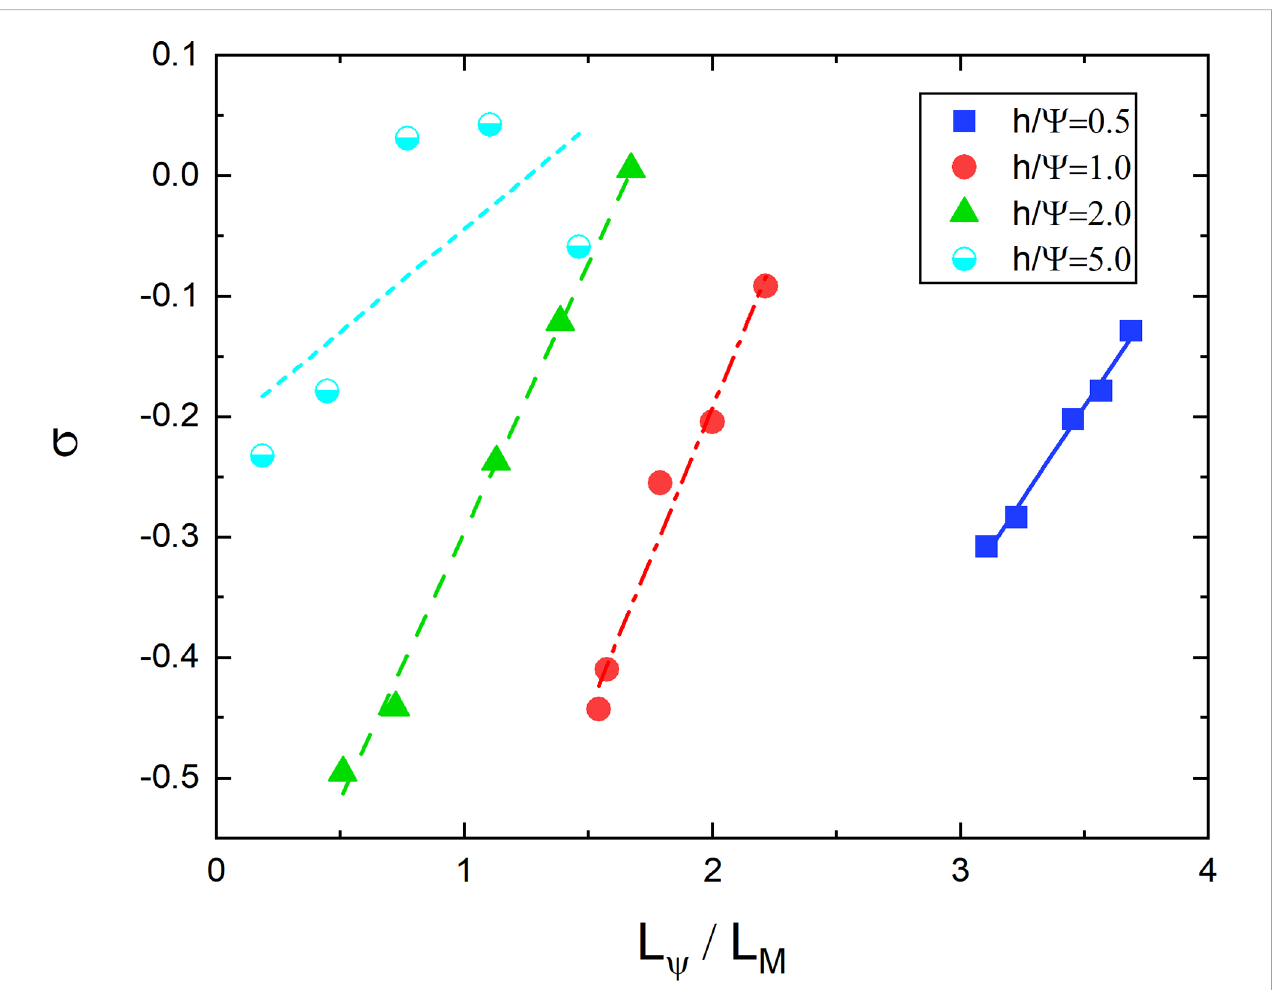
FIGURE 12 s vs L y / L M from the long-time average of M ( x , y , t ) with h / Y =0.5,1,2,5, respectively. The lines are obtained by least square fi tting as